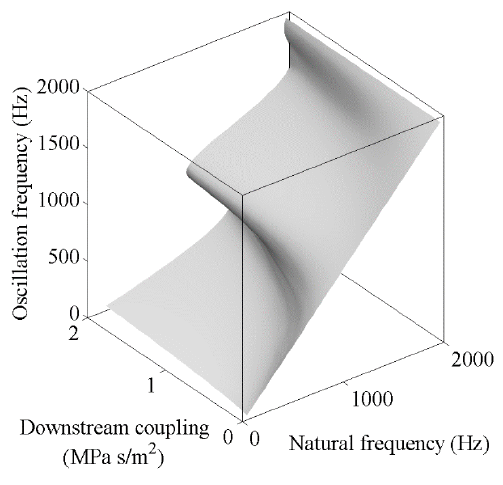
Figure 5. Cusp catastrophe from Equation (16) [20].